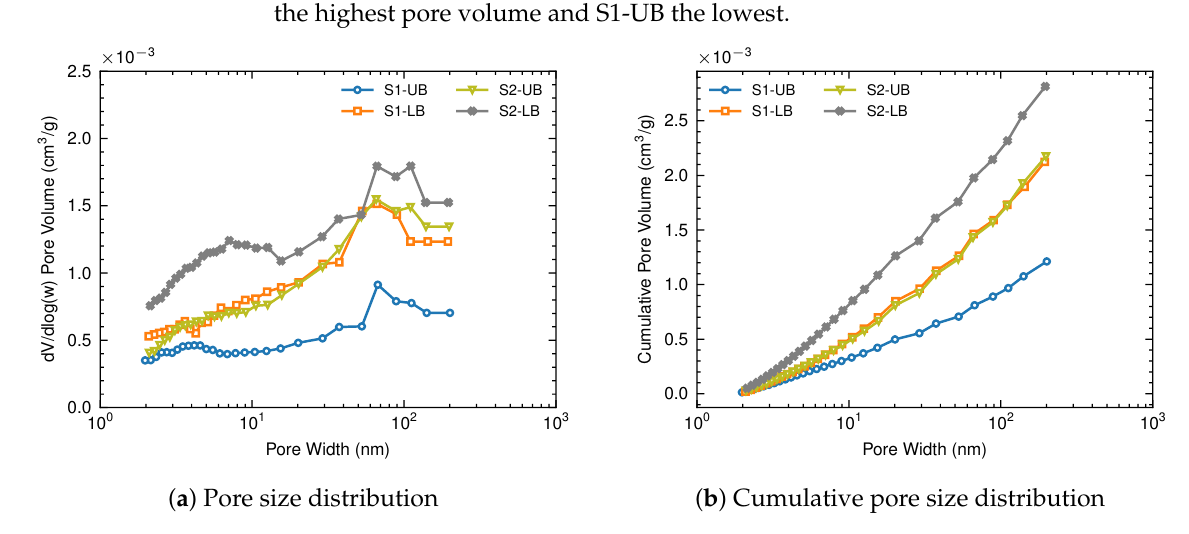
Figure 6. Pore size distribution, as computed from the N 2 desorption data using BJH method: ( a ) the pore throat size distribution; ( b ) the cumulative pore throat size distribution. It should be noted that in the plot of dV/dlog(W), the derivative (y-axis value) was markedly expanded for larger pore sizes. Overall, the pore size distribution analysis indicates that both LB samples have a larger pore volume and adsorption capacity compared to their UB counterpart. Sample S2-LB has a secondary peak for pore width < 10 nm.